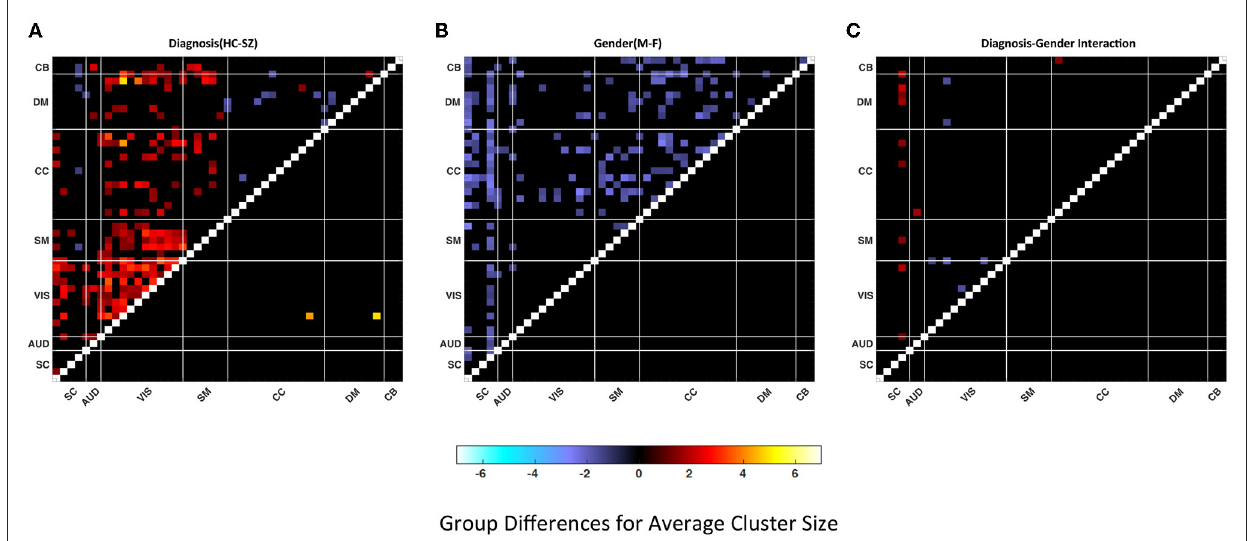
FIGURE5 Group differences in (A) Healthy control—patient, (B) Male–female, (C) Diagnosis-gender interactions for average cluster size. Values are plotted for thresholded p -values* -log 1 0 ( p -value) sign (t-statistic) where p -values masked for significance at p ≤ 0.05 in the upper triangular matrices and thresholded FDR corrected p -values* –log 1 0 ( p -value) sign (t-statistic) where FDR corrected p -values are masked for significance via Benjamini–Hochberg procedure in the lower triangular matrices. Statistics are obtained via linear regression analysis (red shades represent the dominance of HC or F and the blue shades represent the dominance of SZ or